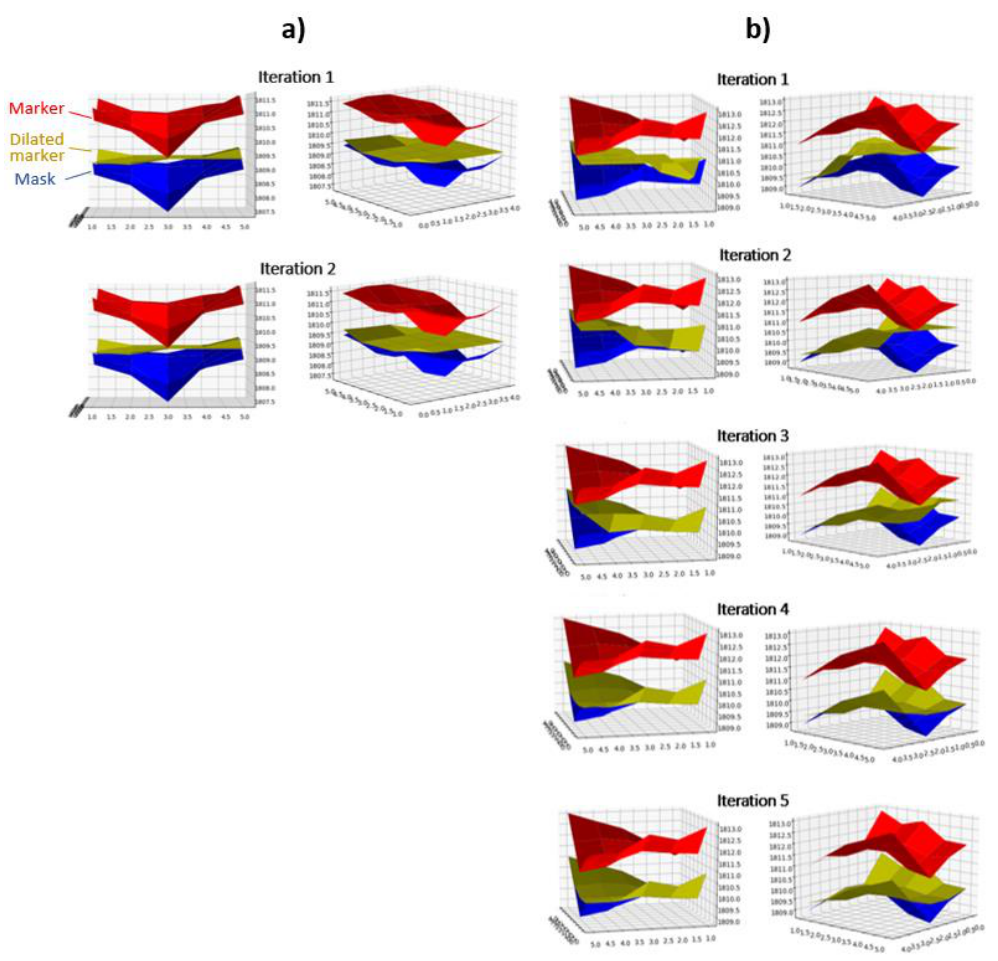
Figure 16. Graphical representation for the study cases of IMR when a gully is detected ( a ), and when it is not detected ( b ). Both ( a ) and ( b ) show the iterative process until the dilated marker remains stable. The results are, nevertheless, satisfactory for MPCA, with a TA of 0.868 and an improved Kappa of 0.615. IMR presents an 0.998 accuracy for PA in non-gully areas, and in this case also 0.971 for UA in gully class. SMPF again produces low percentage scores for gully class, both in PA (0.172) and UA (0.313). IMR and SMPF have in this case lower TA (0.815 and 0.792) and Kappa (0.211 and 0.078) than MPCA.